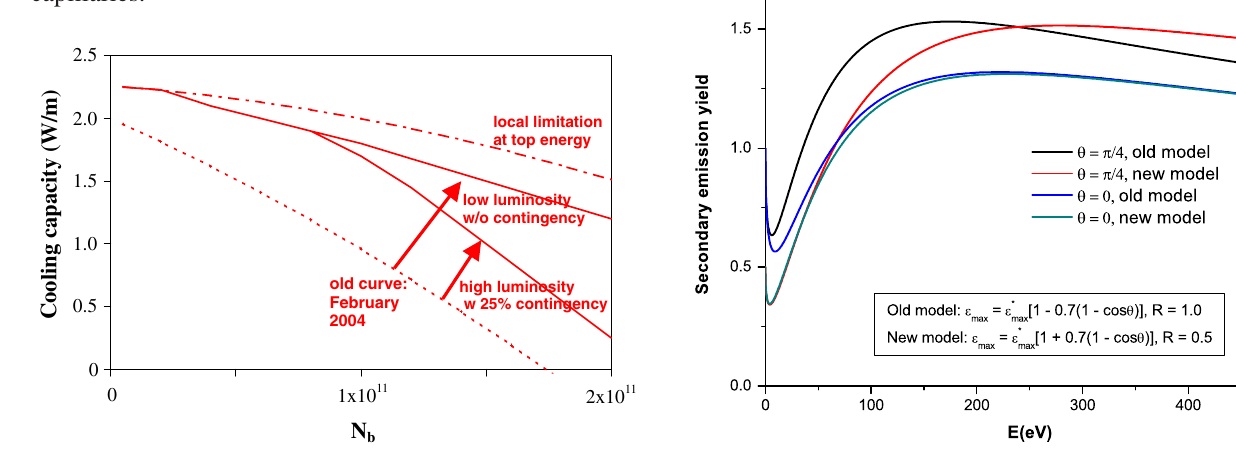
FIG. 5. The secondary-emission yield (cid:1) tot for perpendicular incidence (unchanged) and for incidence at an angle of (cid:6)= 4 according to old [23] and new models [24], with (cid:1) (cid:3) max ¼ 1 : 3 and ¼ 234 : 7 . " max